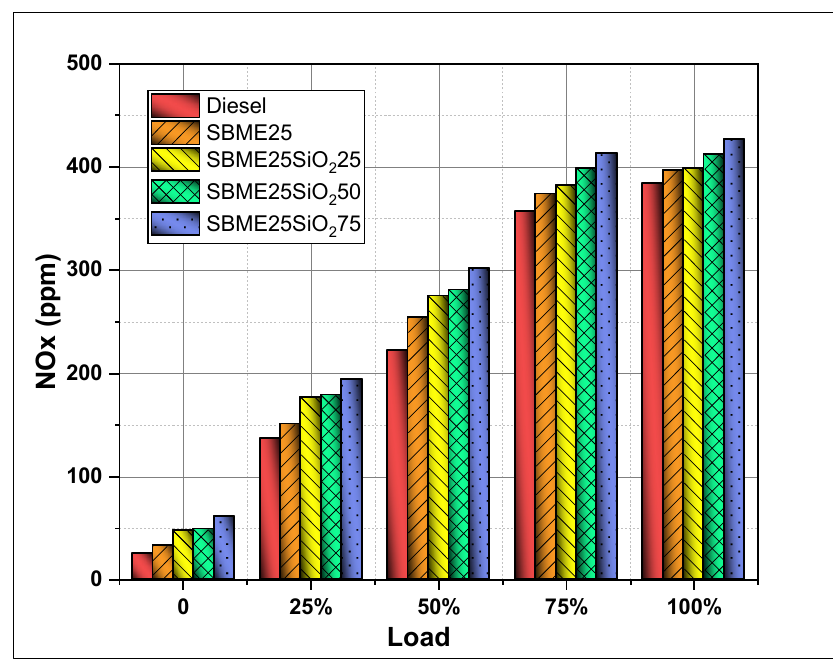
Figure 12. Effect of SiO 2 nano-additives on NOx at varying load.